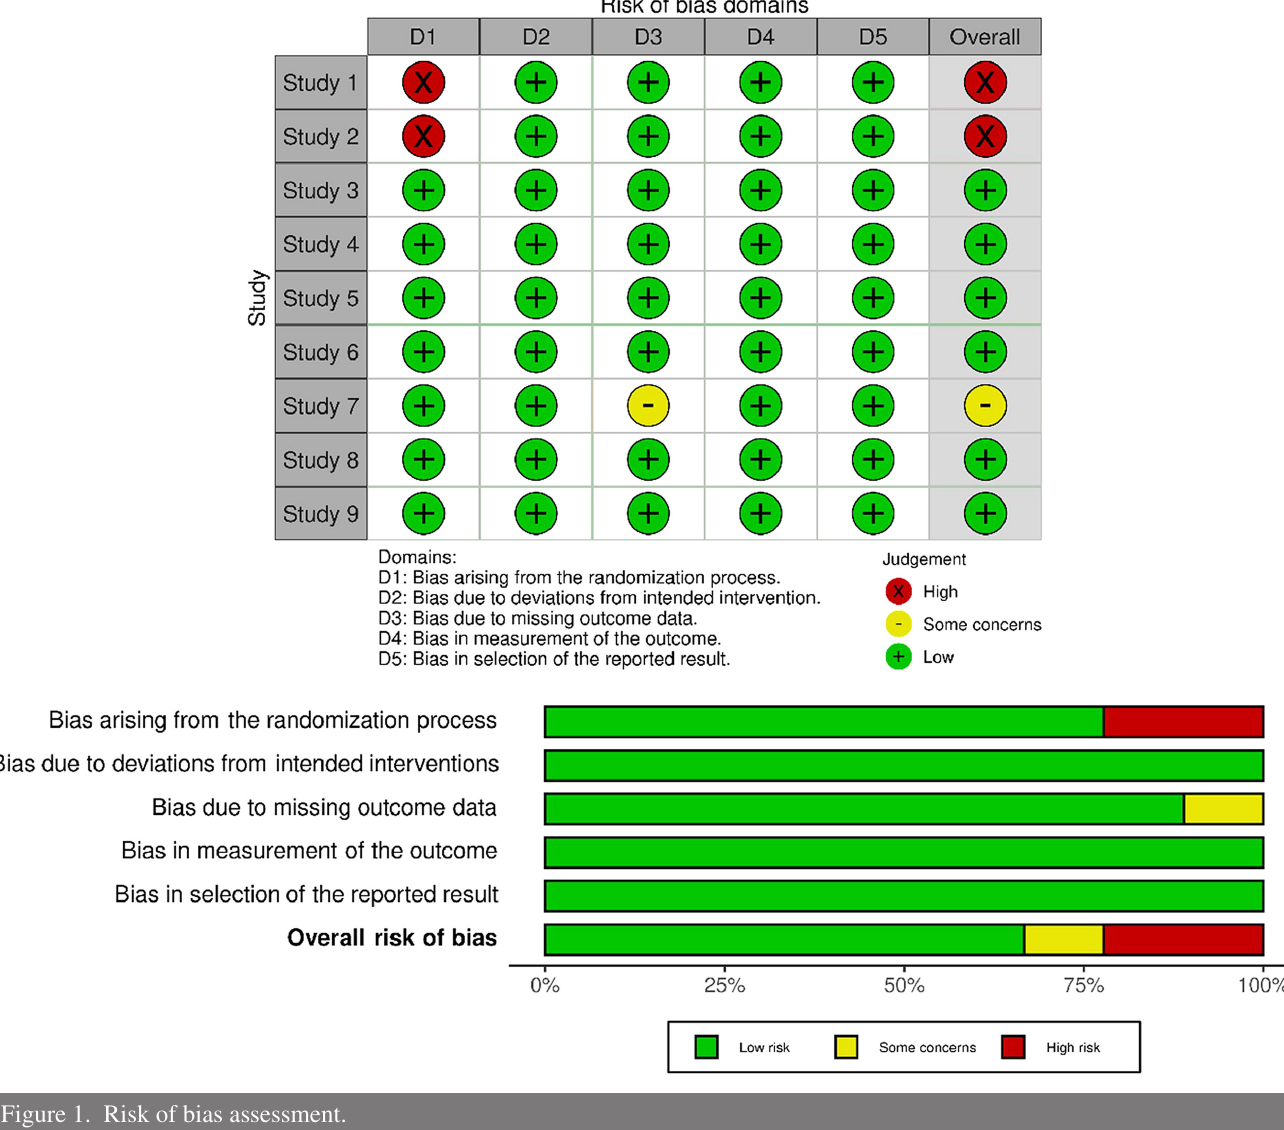
Figure 1. Risk of bias